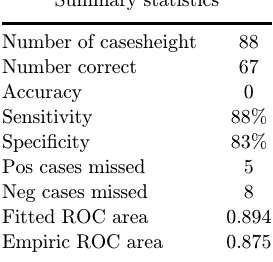
Table 3. Statistical analysis from ROC